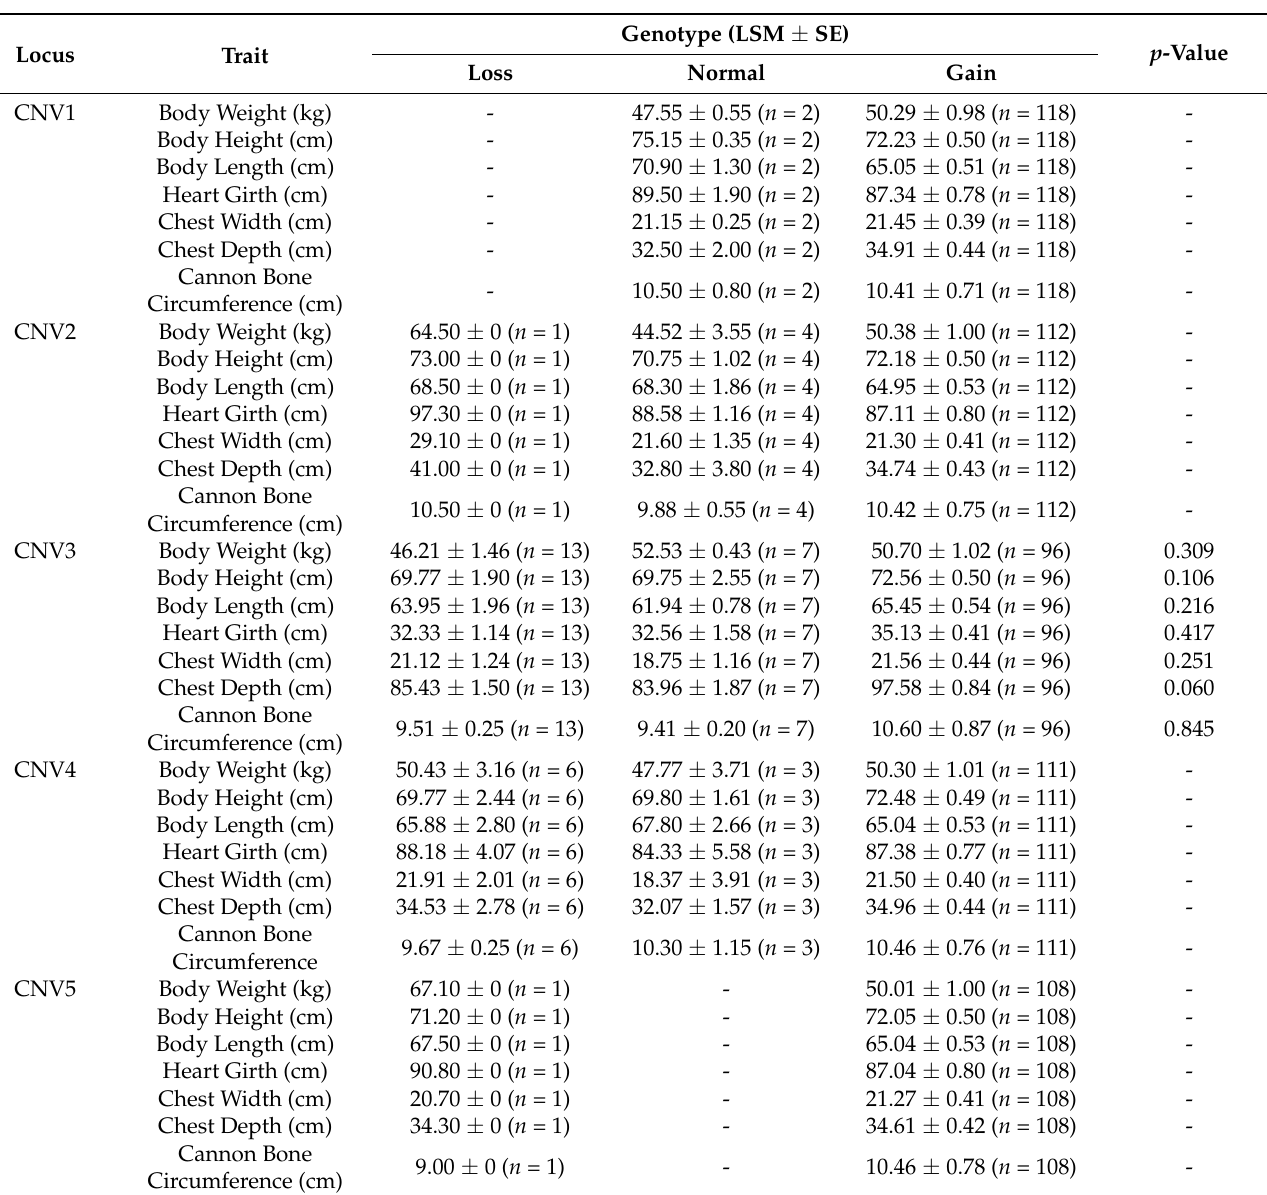
Table 5. Association analyses between morphometric traits and CNVs in Nubian